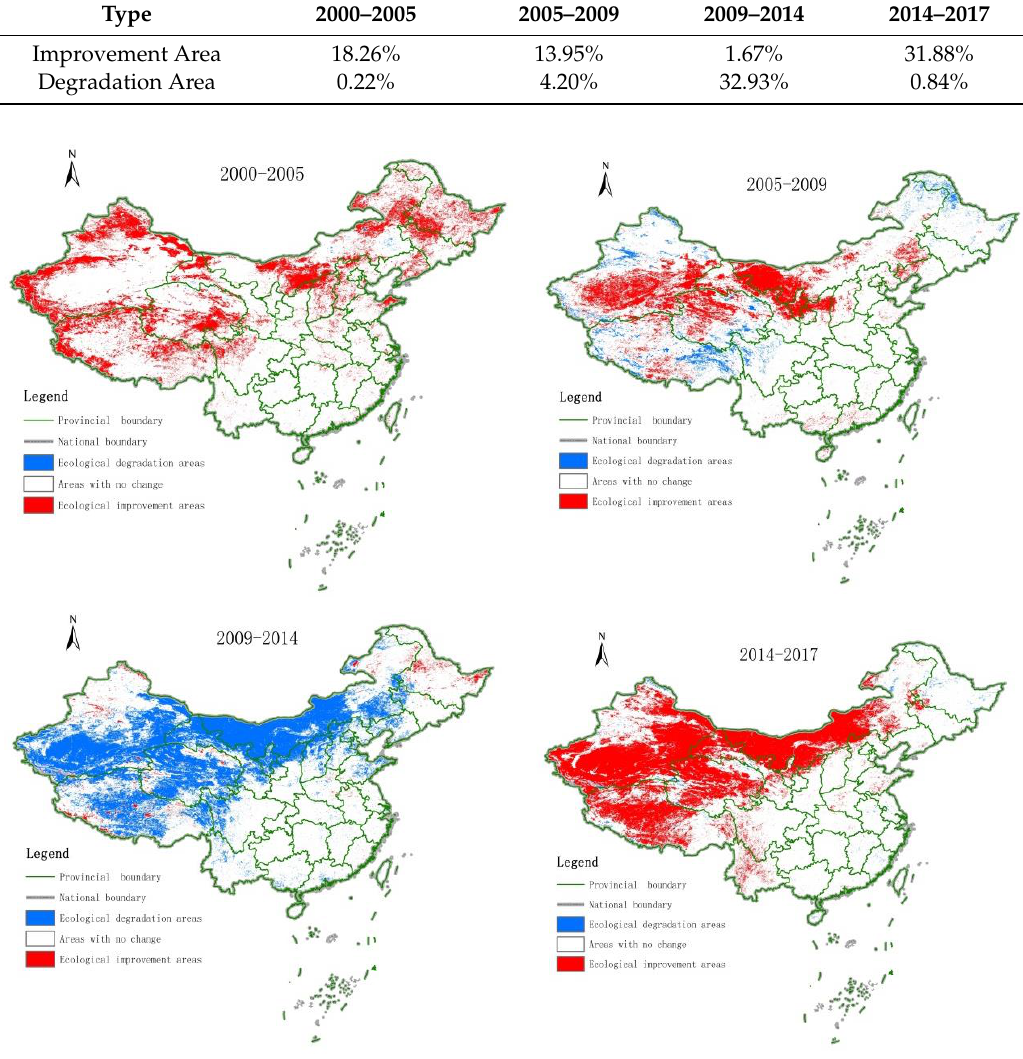
Figure 4. Spatial changing distributions of RSEI in China in